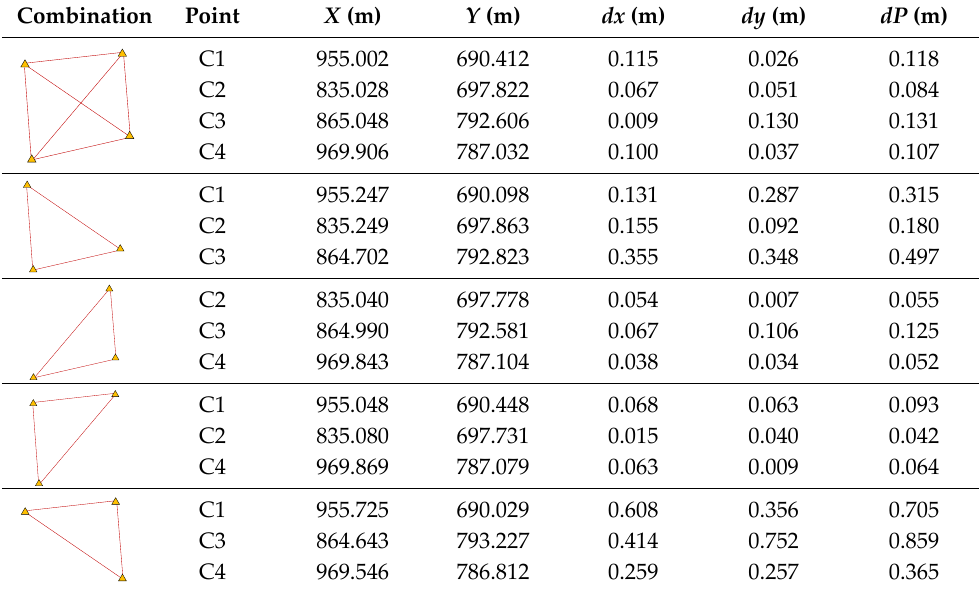
Table 3. The coordinates of control points determined by the relative positioning.